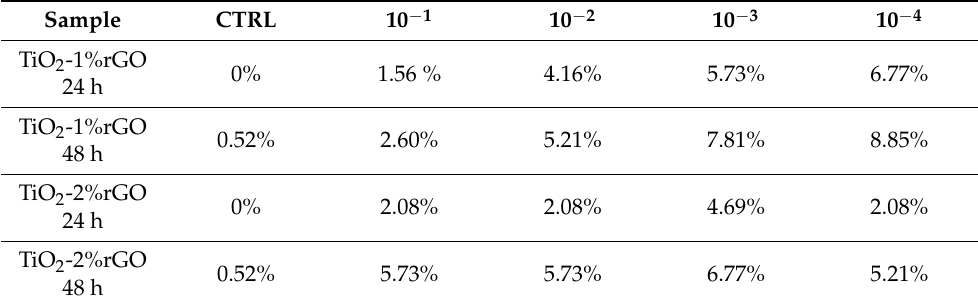
Table 6. Percentages of immobilization of nauplii exposed to TiO 2 -rGO solar at 1 wt.% and TiO 2 -rGO at 2 wt.% at various concentrations (mg rGO-TiO 2 / ml ASPM water) for 24 h, 48 h and controls (CTRL).